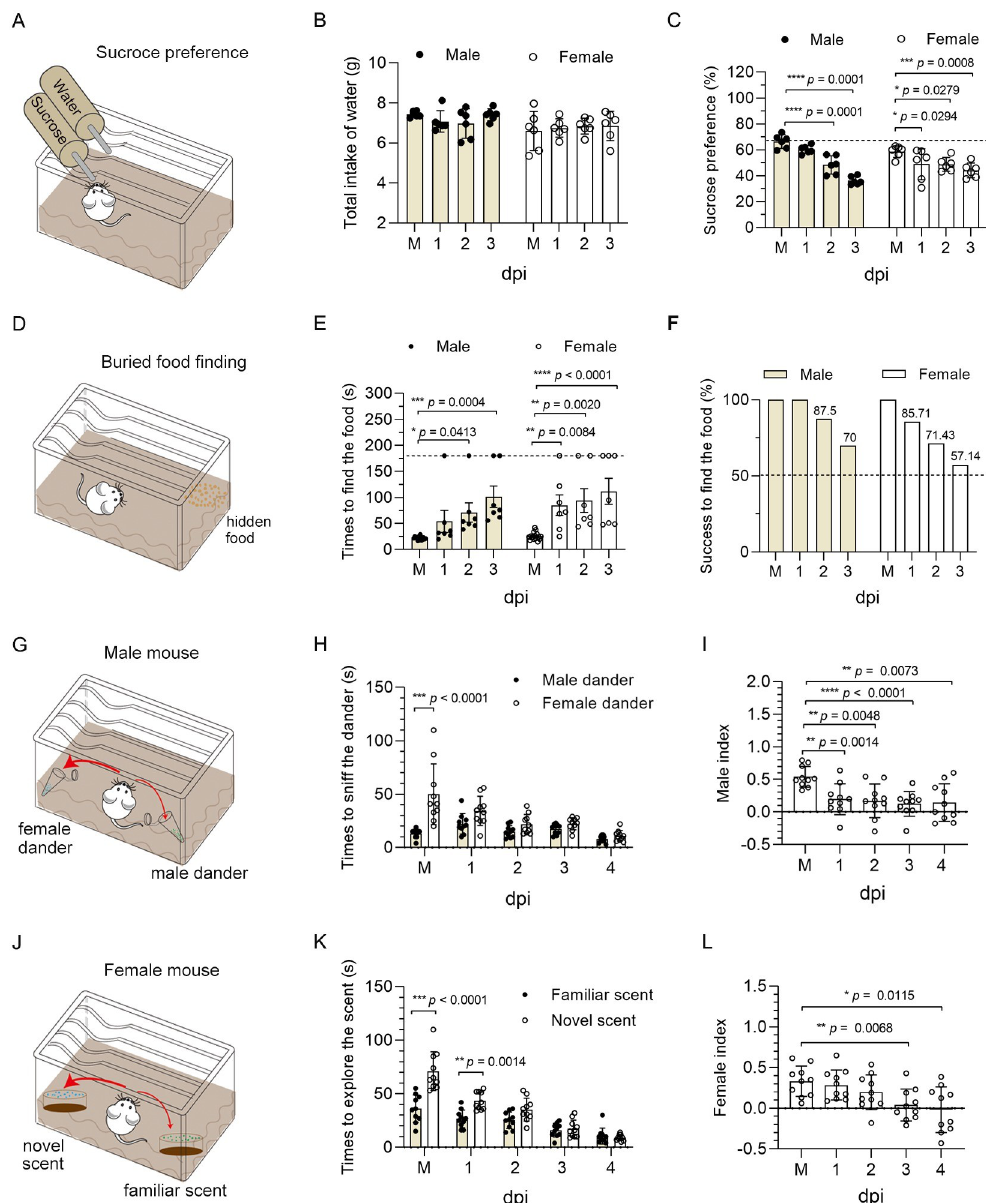
Fig 2. PHEV-associated anosmia and ageusia in BALB/c mice. The 6w male and female BALB/c mice were intranasally inoculated with 10 3.96 TCID 50 PHEV or mock-infected with PBS (M), and a series of behavioral experiments was performed to assess the olfactory and taste functions in mock and PHEV-infected mice. (A ) Schematic diagram of the sucrose preference test (n = 6 per sex). (B) Total intake of water overnight. (C) Sucrose preference of mock and PHEV-infected mice at 1–3 dpi. Each circle represents a mouse. (D) Schematic diagram of the buried food finding test (n = 7 per sex). (E) The time it took for male and female mice to find buried food. The dashed line represents the time limit of 3 min. (F) Percentage of mice that successfully found buried food within 3 min. (G) Schematic diagram of the social scent- discrimination test for male mice (n = 10). (H) Time that male mice spent sniffing male or female dander. ( I ) Preference indices for male mice. (J) Schematic diagram of the social scent-discrimination test for female mice (n = 10). (K) Time that female mice spent exploring familiar or novel scents. (L) Preference indices for female mice. P values were calculated by two-way ANOVA ( B, C, E, H and K ) and the two-tailed Mann–Whitney U test ( I and L ). Data are representative of three replicate experiments and are shown as the means ± SD.